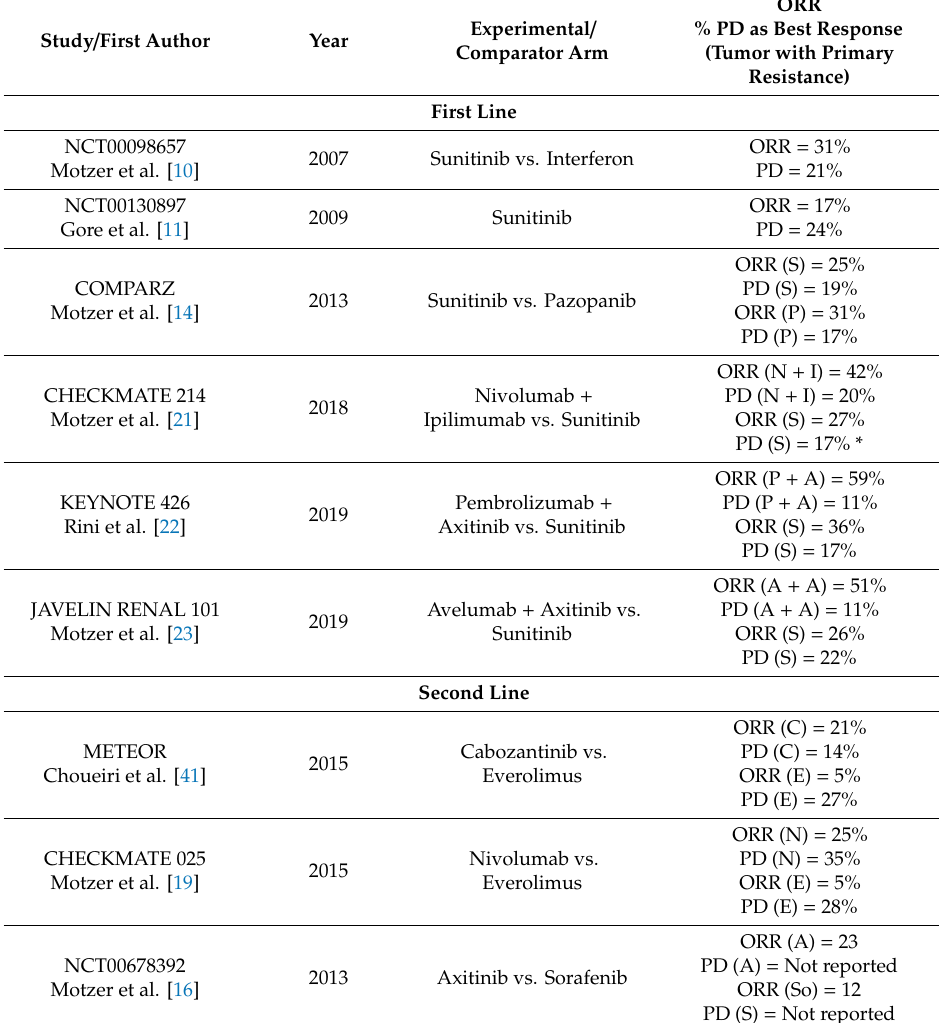
Table 2. Summary table reporting percentage of patients experiencing response and progressive disease (primary refractory patients) in first and second line of